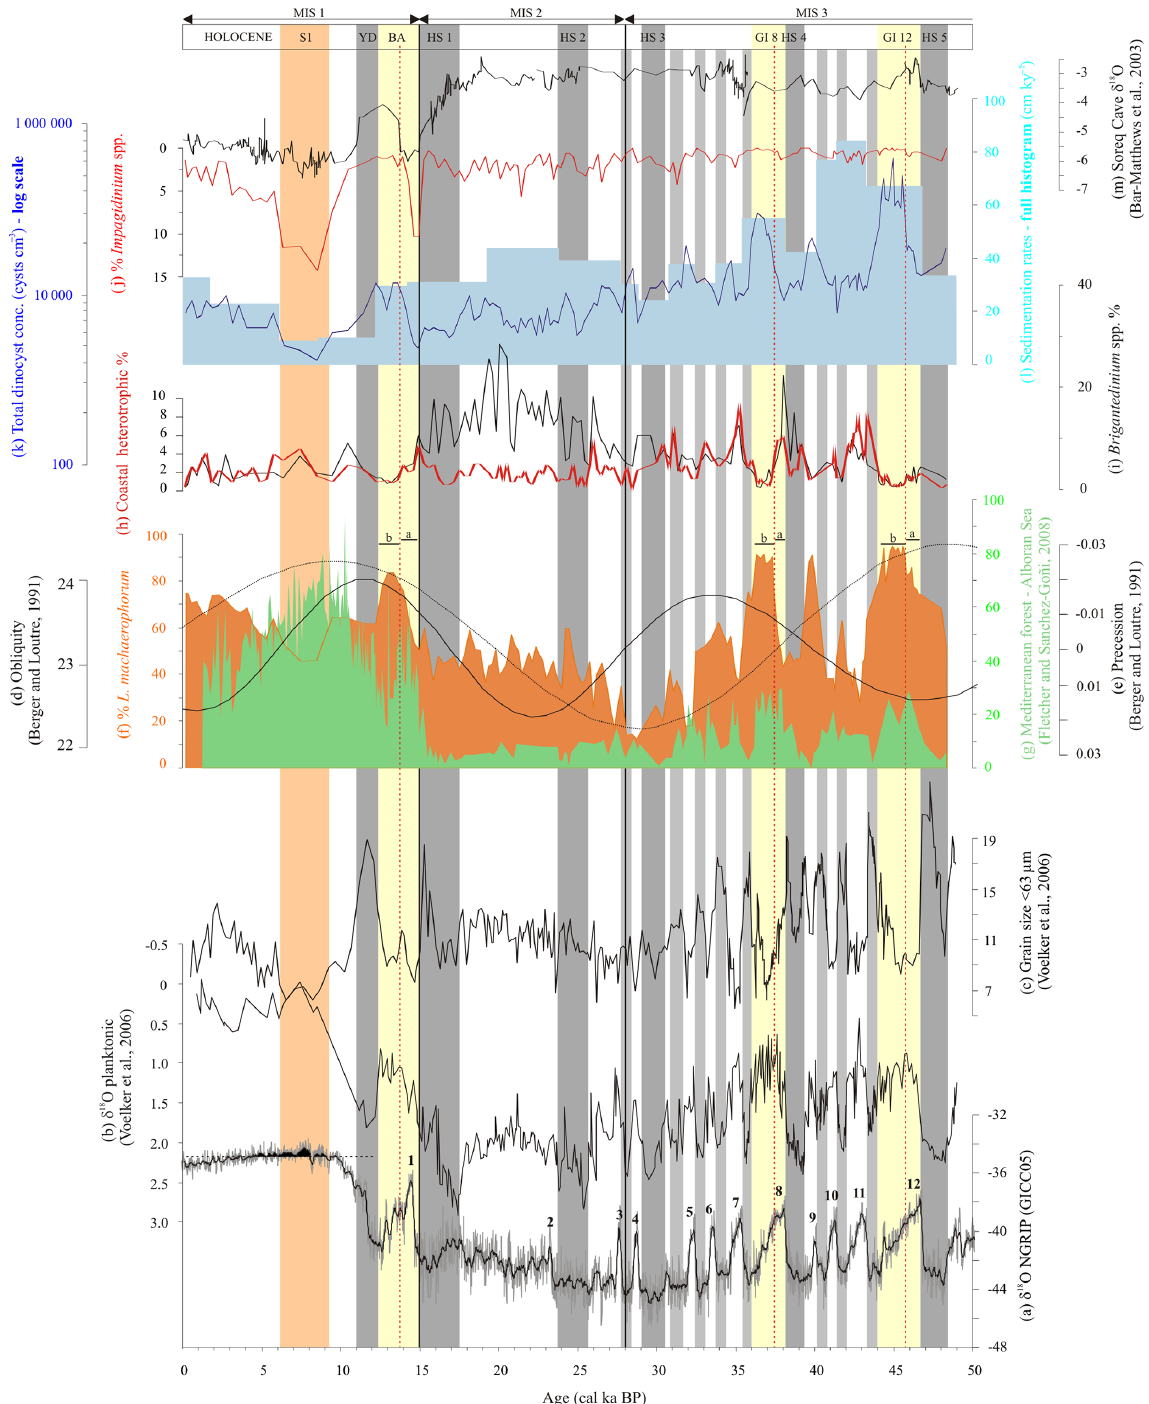
Figure 7. Greenland δ 18 O data (a) in parallel with data from core MD99-2339: planktonic δ 18 O (b) and mean grain size <63µm (c) , over the last 50ky. Dinocyst data (f, h, i, j) from core MD99-2339 are also depicted vs. western (pollen, Alboran Sea, g ) and eastern ( δ 18 O, Soreq Cave,m) Mediterranean records, as well as orbital parameters (d, e) . Sedimentation rates (l) calculated from the new age model of core MD99-2339 echo total dinocyst concentrations (k) . Greenland Interstadials (GI) 1 (Bölling–Alleröd: BA), 8 and 12 are highlighted with yellow bands and are characterized by a bipartite structure labelled “a” and “b” for the first and second phases, respectively. Grey bands indicate Heinrich Stadials (HS) and the Younger Dryas (YD). The orange vertical band indicates the time interval corresponding to Sapropel 1 (S1) formation